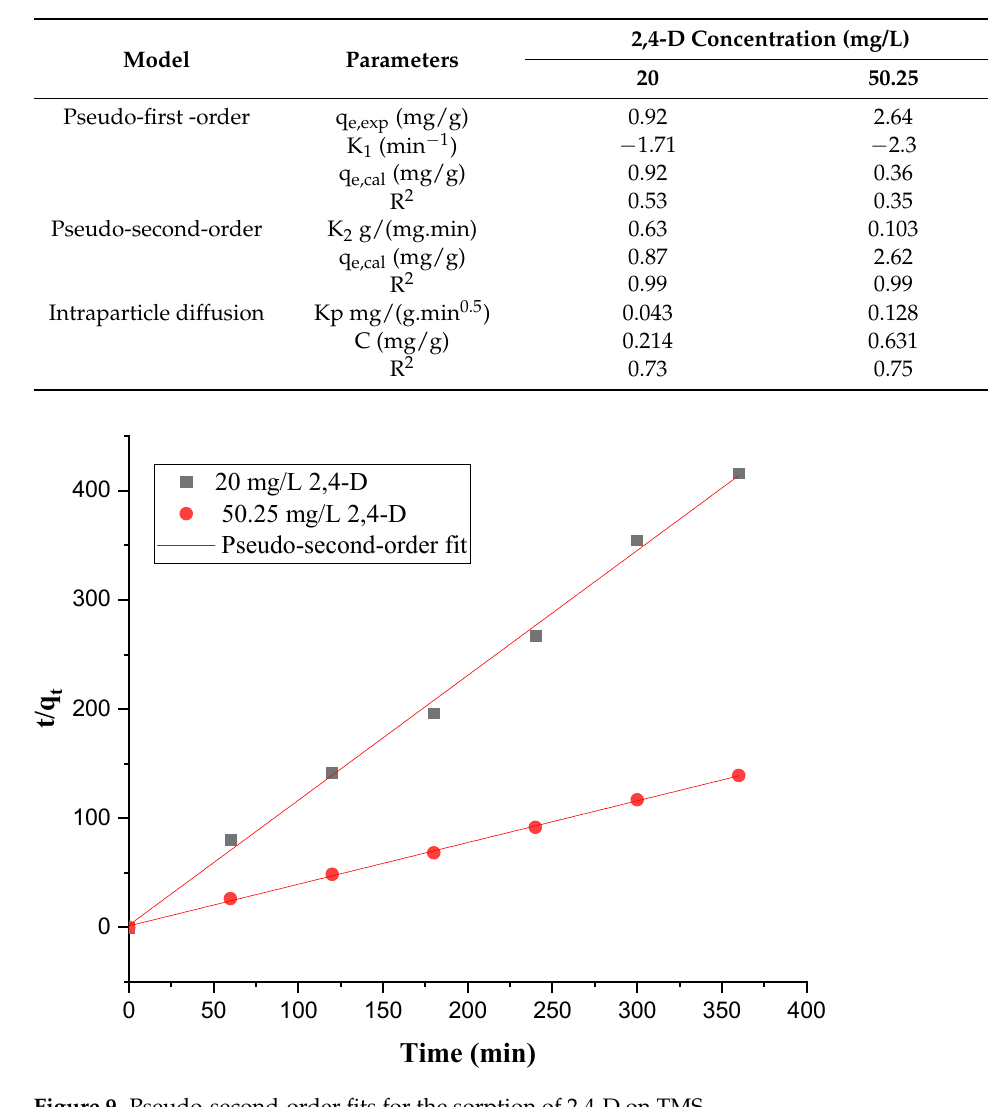
Figure 9. Pseudo-second-order fits for the sorption of 2,4-D on TMS.